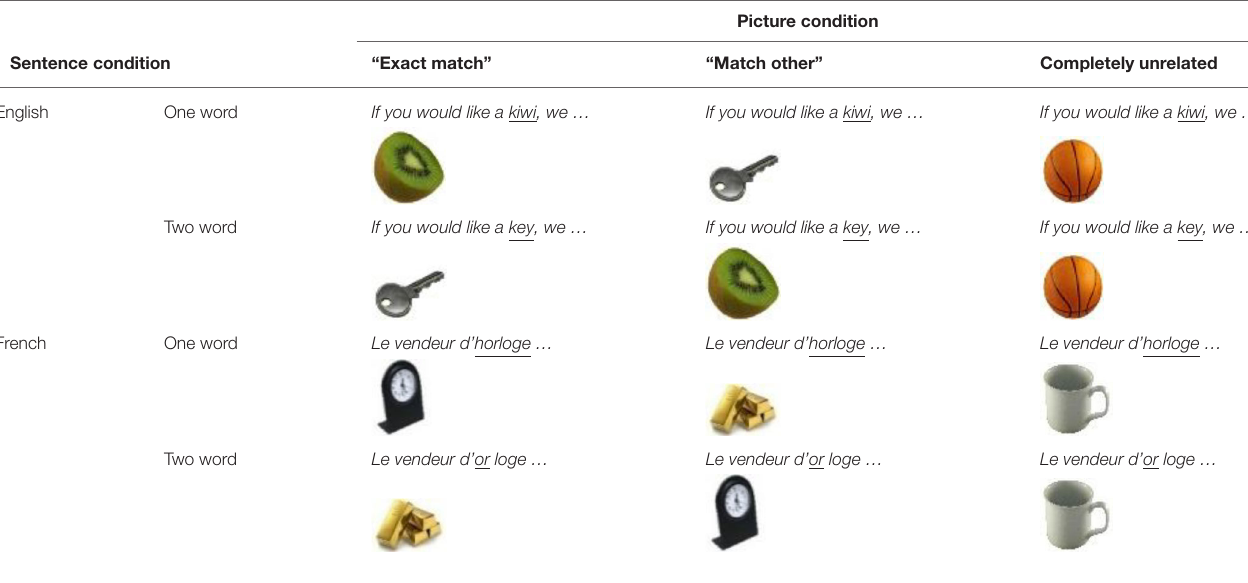
TABLE 3 | Schematic representation of sentence and picture condition combinations in English and French trials.